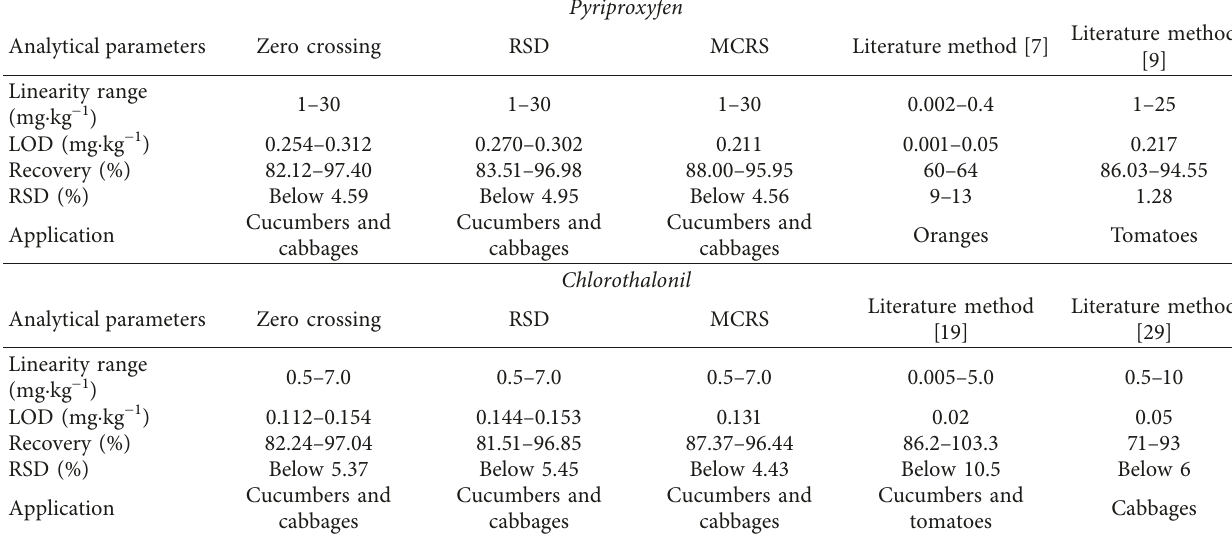
Table 7: Comparison of the proposed methods with some other